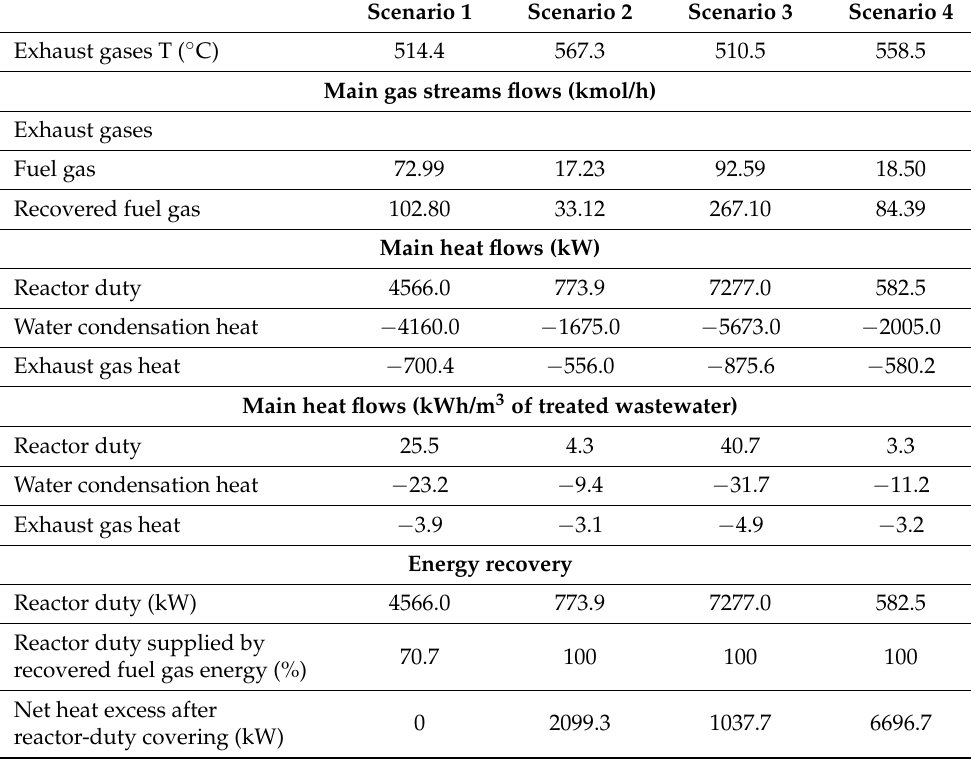
Table 5. Heat integration results for the proposed operating